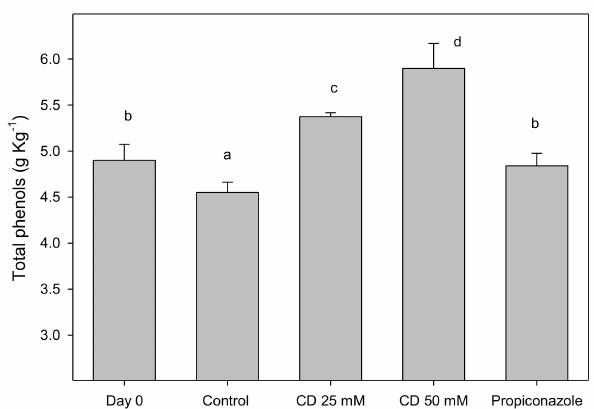
Figure 4. Total phenolics concentration (g kg − 1 gallic acid equivalent), in peel of control, 25 or 50 mM of HP- β -CD-thymol or propiconazole treated “Fino 49” lemon fruits at harvest (day 0) and after 10 d of storage at 20 ◦ C, in preventive experiment. Data are the mean ± SE. Di ff erent letters show significant di ff erences ( p < 0.05) among treatments after 10 days of